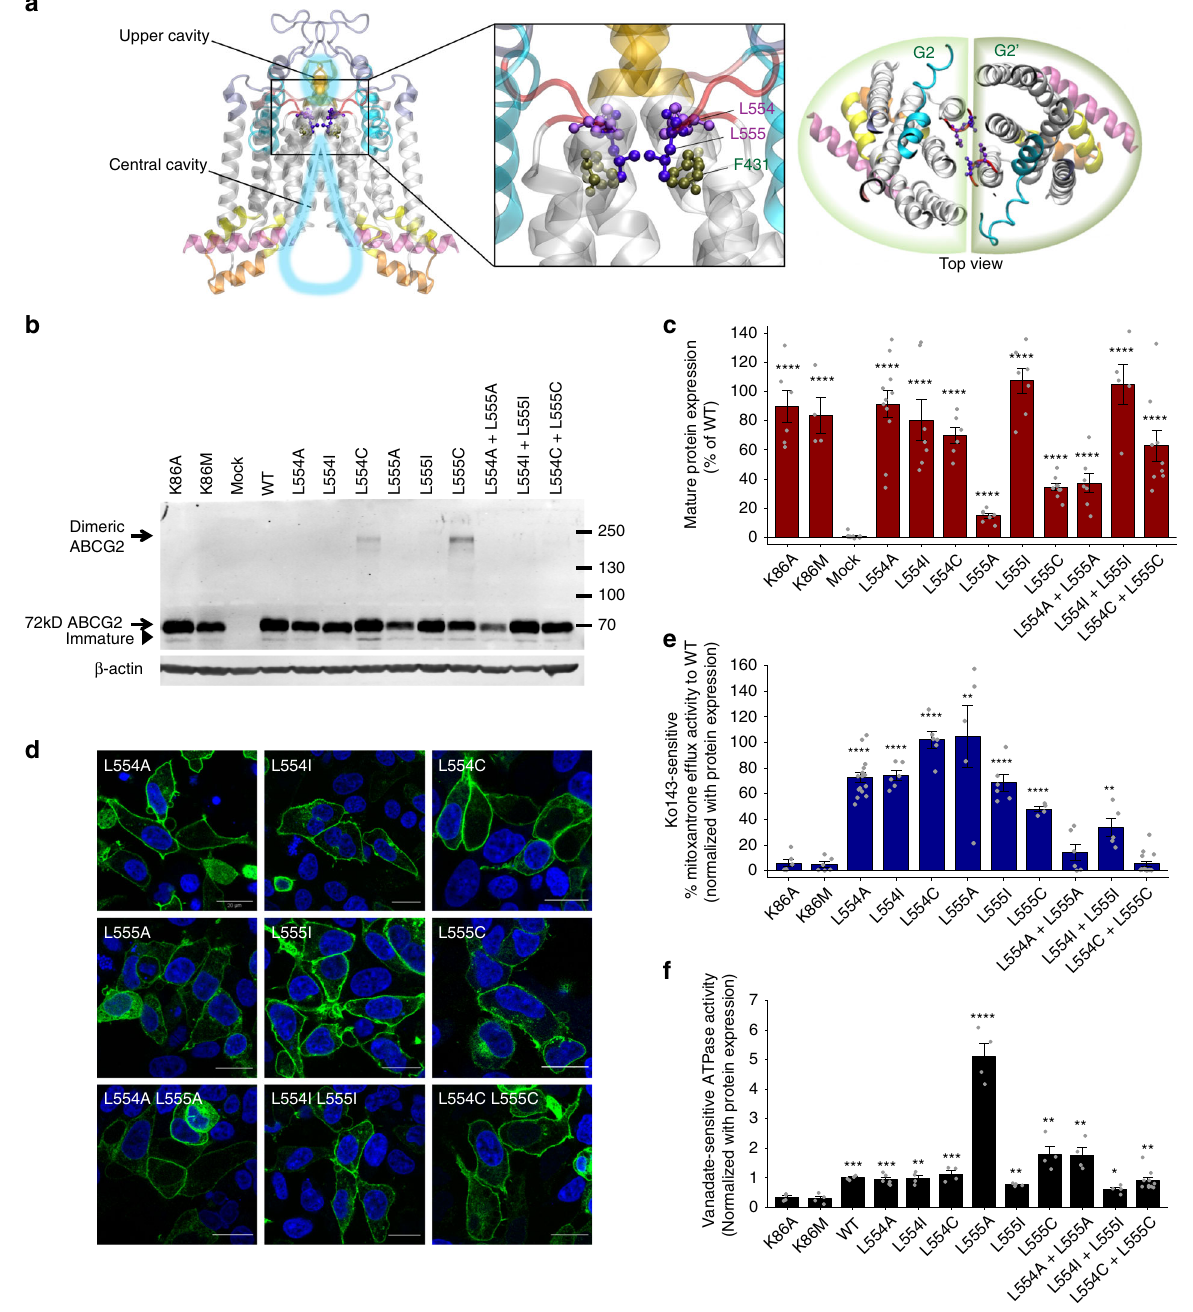
Fig. 4 The di-leucine motif at the top of the central cavity is critical for ABCG2 function. a Ribbon representation of homo-dimeric ABCG2 in the ATP-free state. The zoom-in view shows the positions of L554 and L555 (purple balls-and-sticks) subtending the extracellular membrane border between the central and upper cavities. F431 (dark green balls-and-sticks) locates just below the di-leucine valve. b Immunodetection is shown for ABCG2 variants stably expressed in HEK293 cells and detected by the anti-ABCG2 (BXP-21) antibody. ABCG2 monomers migrate at ~72 kDa, while dimeric ABCG2 is located above. β -Actin was used as an internal loading control. c Odyssey-based quanti fi cation of stably expressed ABCG2 variant, normalized against WT ABCG2, is plotted. Data are from several independent experiments ( n = 3 – 13). All results are represented as means ± SEM; **** P < 0.0001 vs. mock control. Gray dots represent values from independent biological replicates. d Membrane localizations of GFP-tagged ABCG2 variants (green) are shown. Nuclear DNA was stained with DAPI (blue). Microscopy data are from duplicate experiments. Scale bars in microscopy images correspond to 20 µ m. e Normalized mitoxantrone ef fl ux activity of di-leucine valve mutants is plotted. Ko143-sensitive ef fl ux activity is given as percentage activity of the WT control ( n = 4 – 18). Bar graphs are shown as means± SEM; **** P < 0.0001; ** P < 0.01 vs. K86M. Gray dots represent values from independent biological replicates. f Vanadate-sensitive ATPase activities of ABCG2 variants stably expressed in HEK293 cells are quanti fi ed. Data are from independent experiments ( n = 4 – 10), using three different batches of membrane preparations. Double mutation L554C L555C samples were prepared from four clones of stable cell line. Data are normalized and given as fold changes relative to WT. All data are means ± SEM; **** P < 0.0001; *** P < 0.001; ** P < 0.01; * P < 0.1 vs. negative control. Gray dots represent values from independent biological